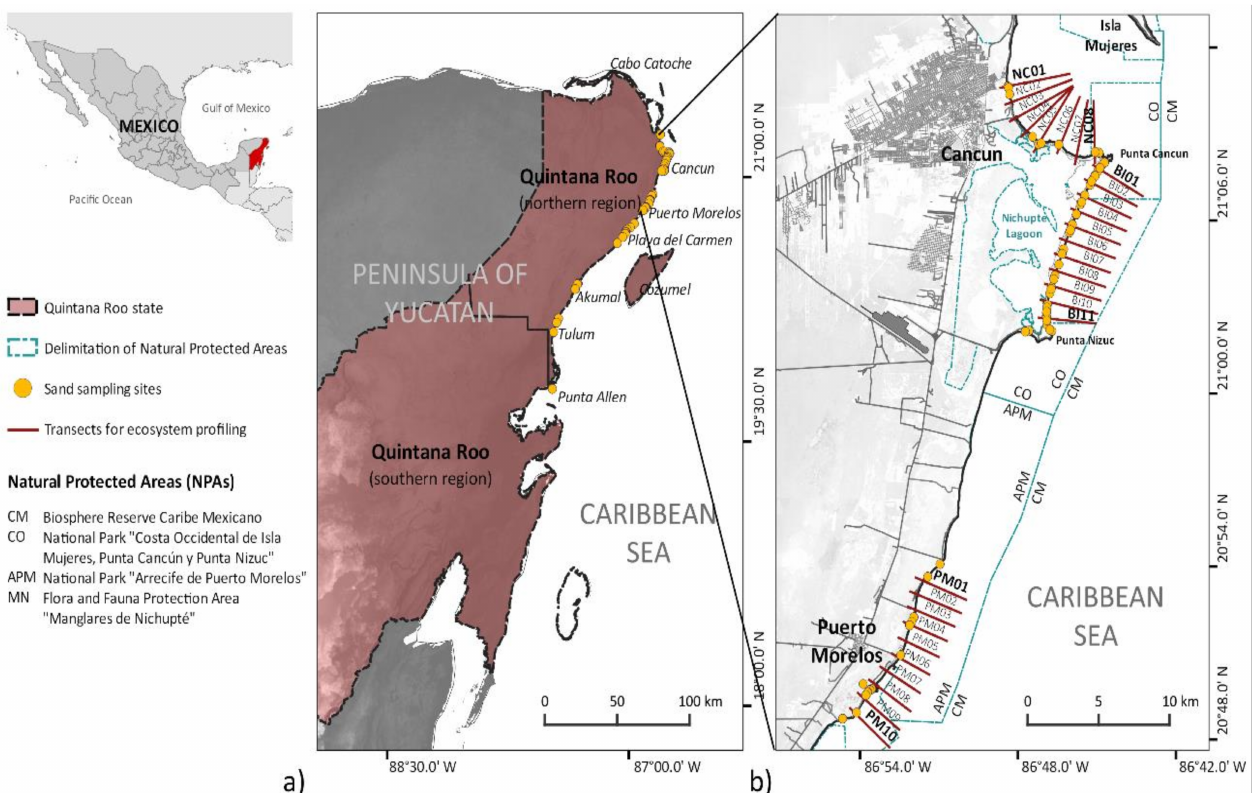
Figure 1. ( a ) Study area in the state of Quintana Roo, Mexico, and location of sand sampling sites. ( b ) Transects for coastal ecosystem profiling, sand sampling sites and surrounding Natural Protected Areas at the case study locations of Cancun and Puerto